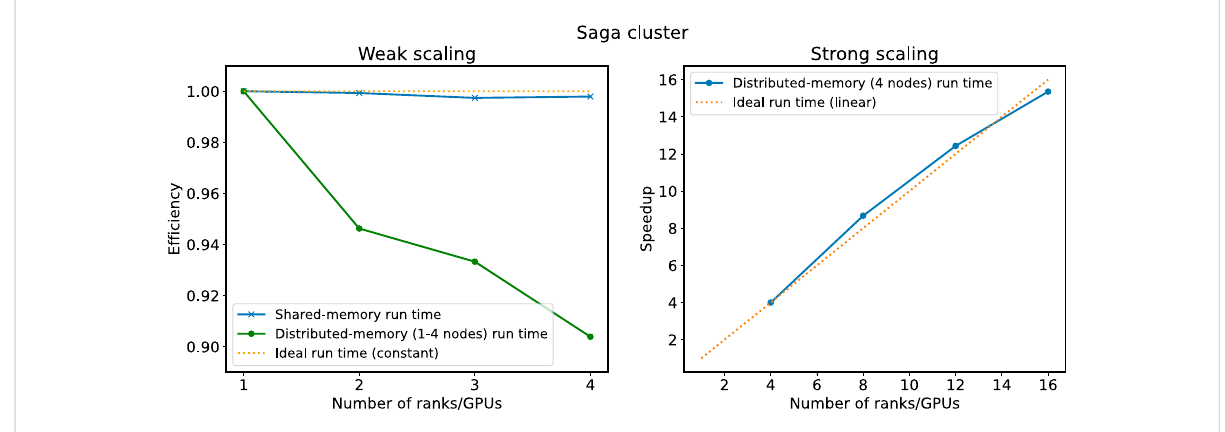
FIGURE 8 Results from scaling experiments on the Saga cluster. Weak scaling (1 – 4 GPUs on a single node and 1 – 4 nodes with one GPU on each node) is shownintheleftpanelandstrongscaling(4 – 16GPUsdividedequallybetweenfournodes)isshownintherightpanel.Runtimesarenormalizedwith respect to the single rank/GPU experiment for weak scaling and the four ranks/GPUs experiment for strong